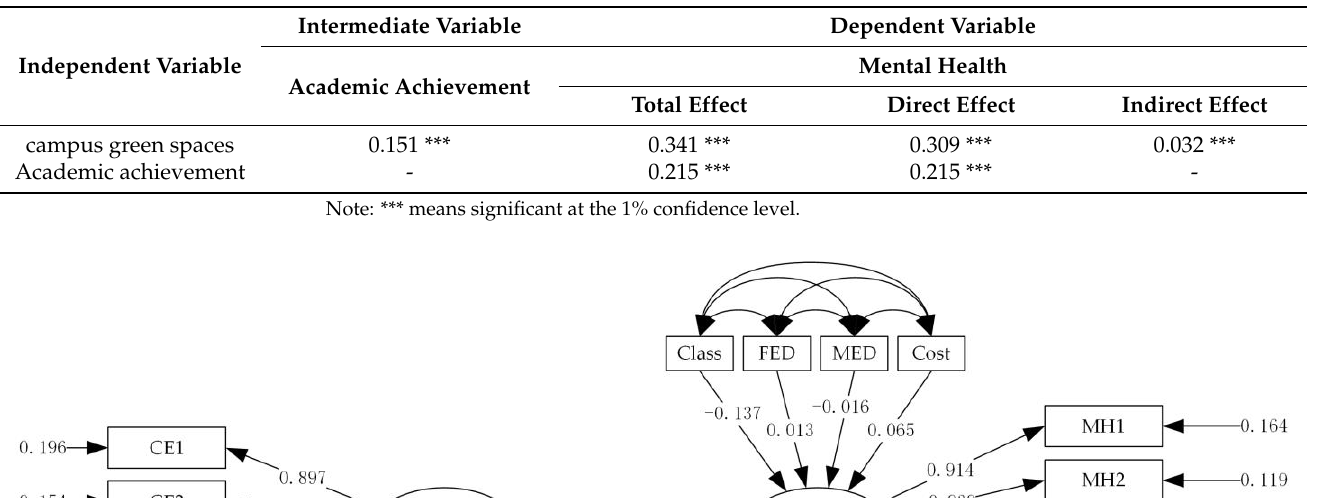
Table 4. Total, direct and indirect effects of the full sample model.